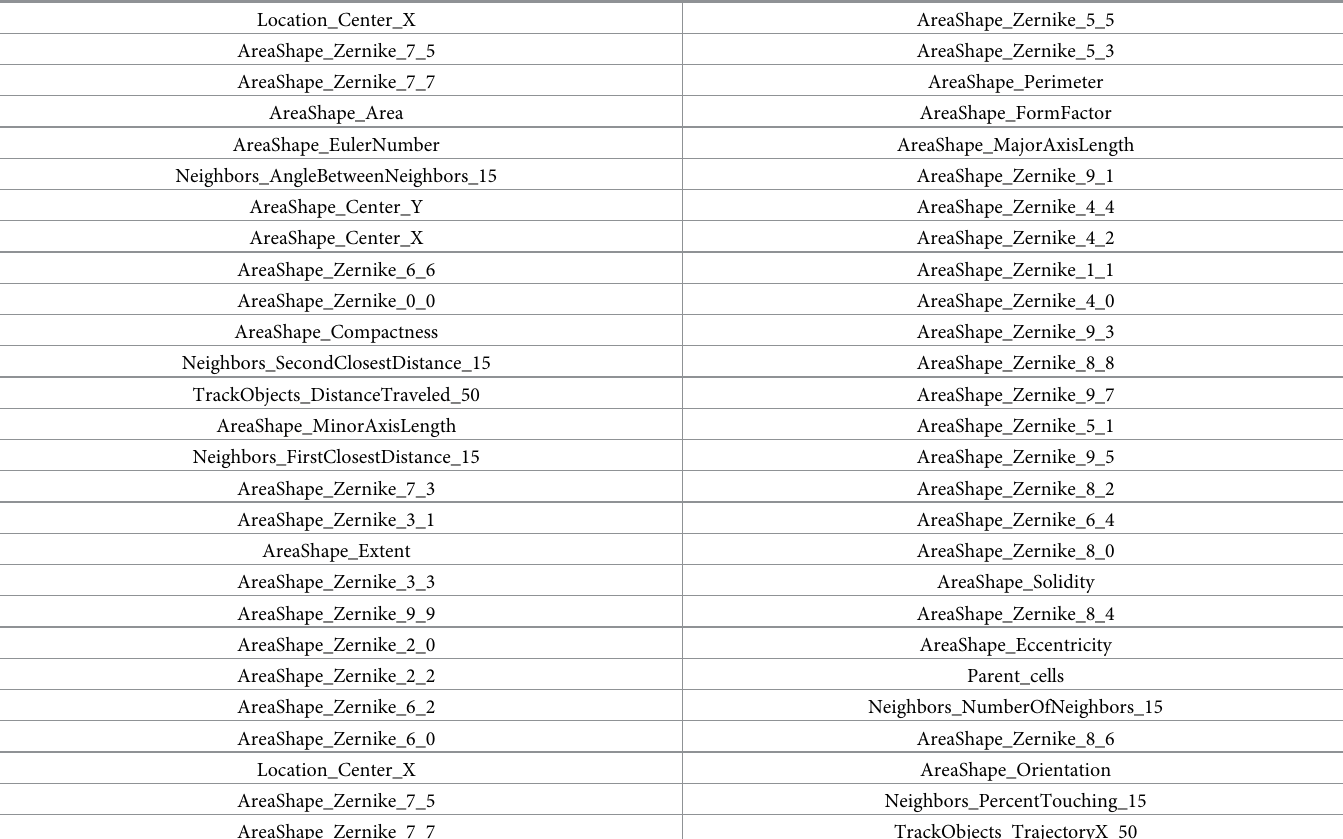
Table 1. All properties measured by CellProfiler at every 15 min time point and considered in further